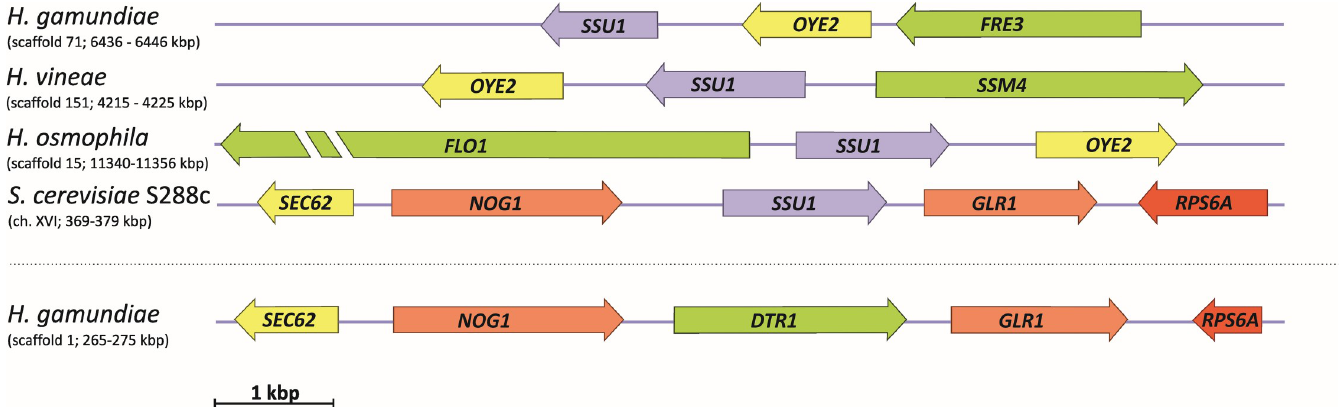
Fig 3. Schematic gene organization around the putative sulfite pump gene SSU1 (purple) in H . gamundiae sp. nov. and related species. Green arrows indicate genes without synteny, while the color intensity of arrows from yellow (40–50% nucleotide similarity), to orange (80–90% similarity), to red (more than 90% similarity), indicate the level of conservation between orthologous genes. Gene sizes and distances are approximately to scale. Numbers in parentheses indicate scaffold number and location of genes in the assembled genome.